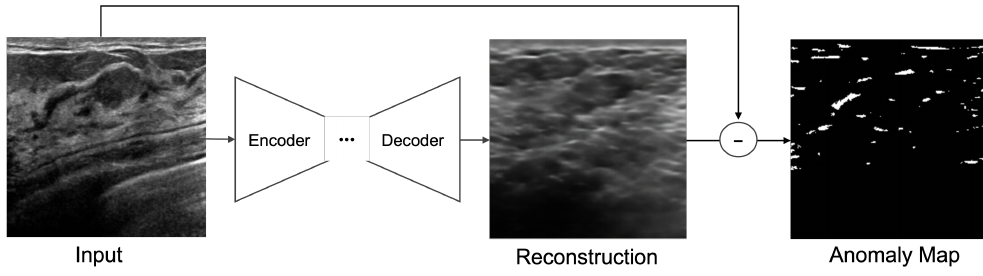
Figure 5. Anomaly detection by pixel difference between an original image and reconstructed image on